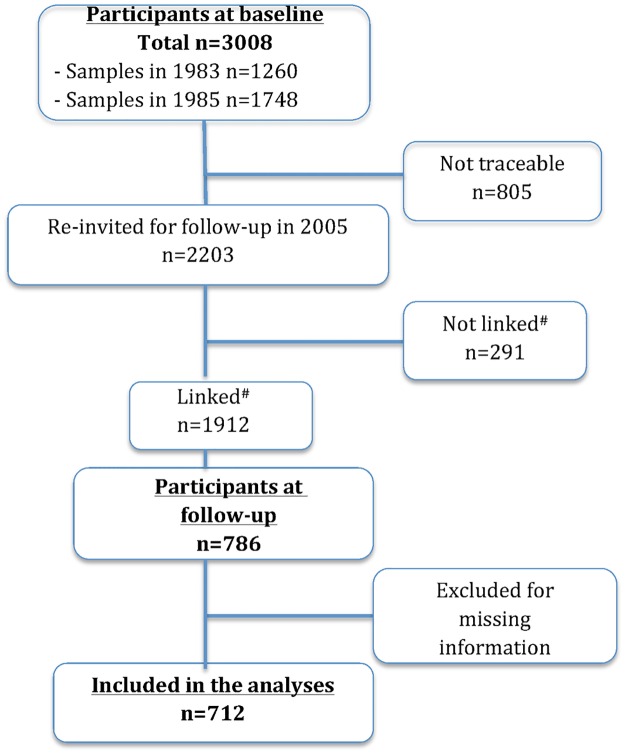
Study population flow chart.Fig 1 provides information on the participants flow between the baseline and follow-up surveys.